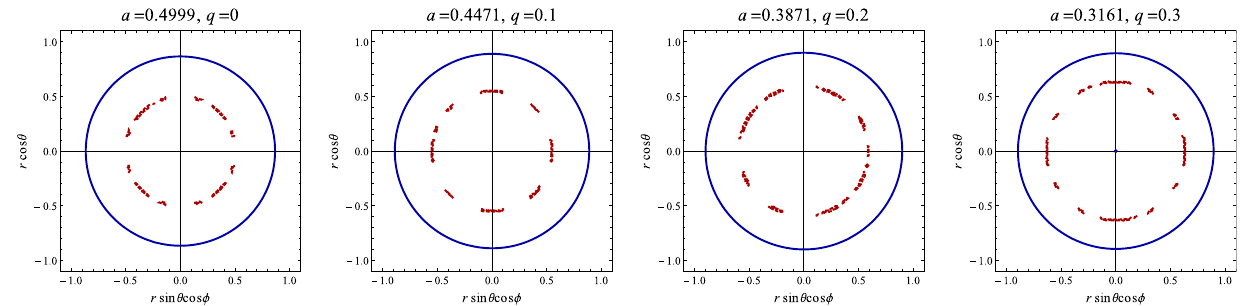
Fig. 3 The cross section of the event horizon, static limit surface, and ergoregion for different values of q with a fixed rotation parameter a for the extremal five-dimensional EMCS black hole when the two horizons coincide. The blue lines indicate the static limit surface and the red ones represent